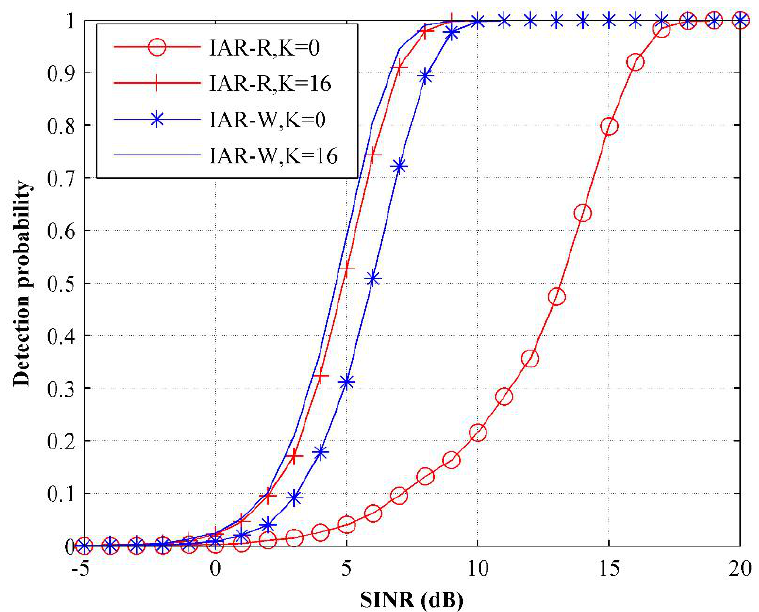
Figure 3. P d versus SINR of the IAR-Rao and of the IAR-Wald for N = 16, L = 8, and various K .